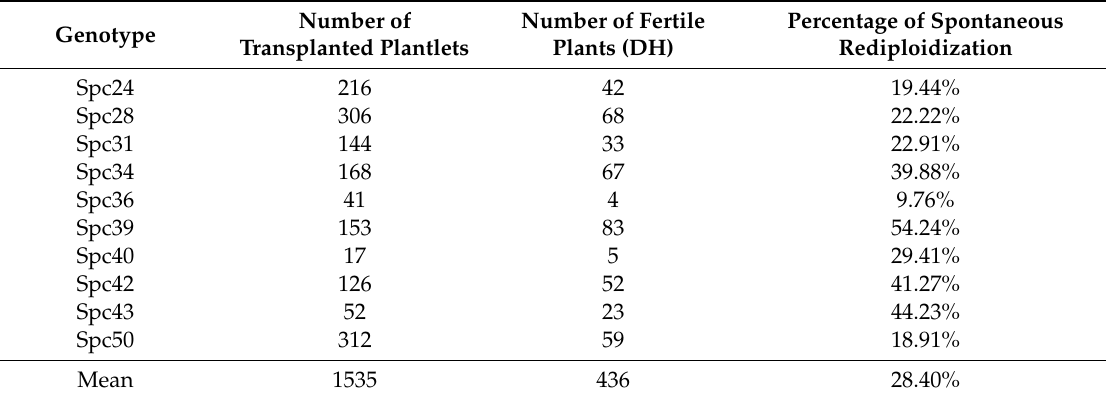
Table 9. Percentage of spontaneous rediploidization in spelt genotypes.